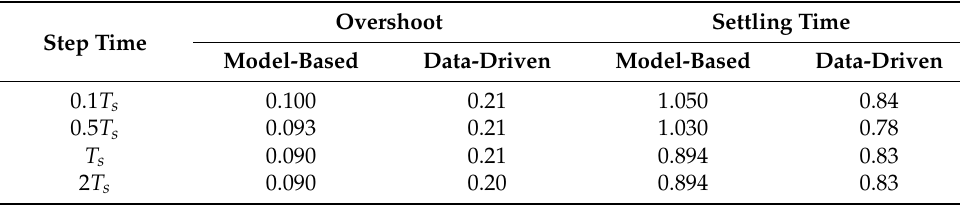
Table 2. Controller performance during transient faults using different time